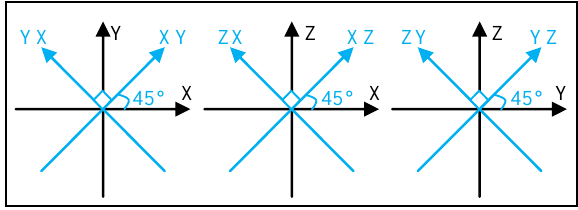
Figure 5. Three Cartesian axes and six non-Cartesian axes on which points are projected